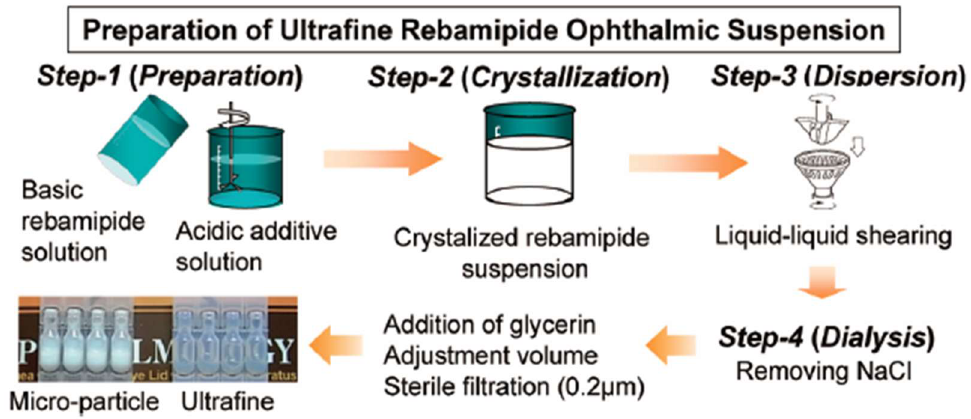
Figure 2. Schematic illustration for the preparation of rebamipide ultrafine suspension. Reprinted with permission from [33] . Copyright 2017 The Pharmaceutical Society of Japan.